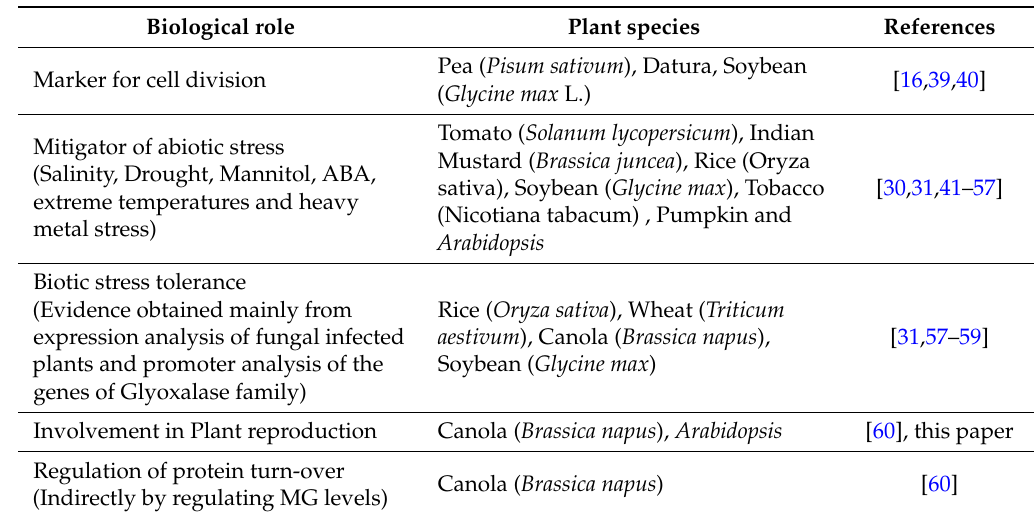
Table 1. Biological roles of glyoxalases in